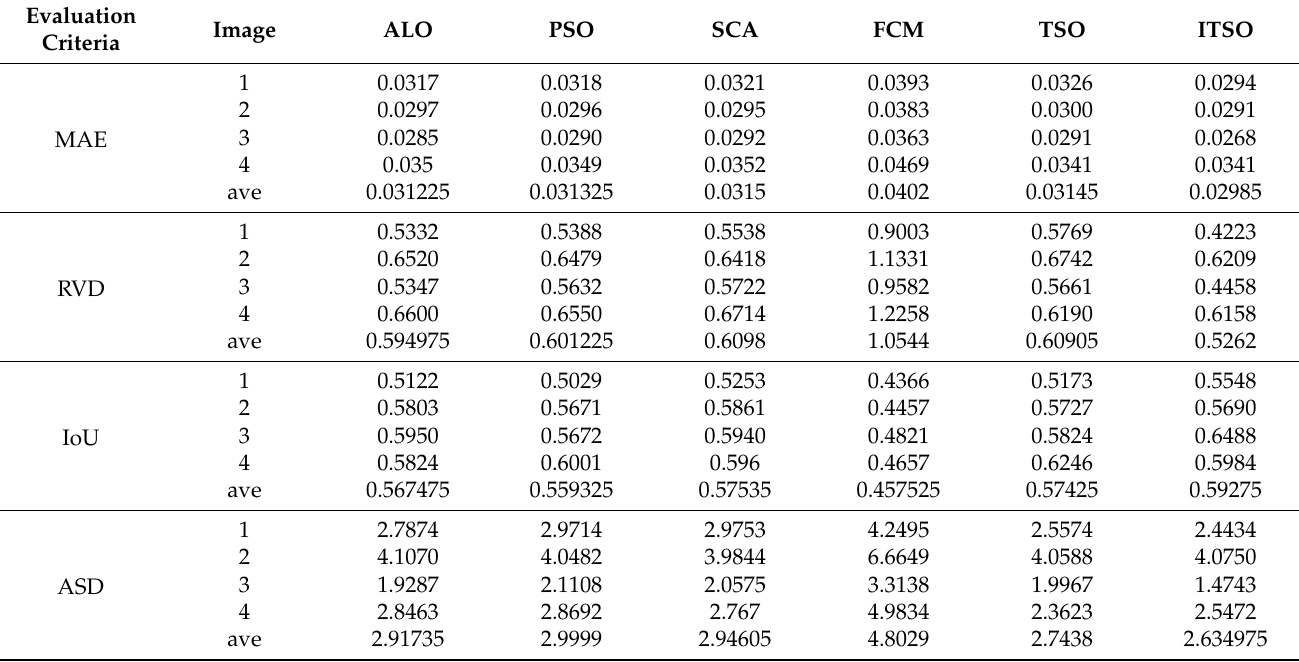
Table 5. Performances of